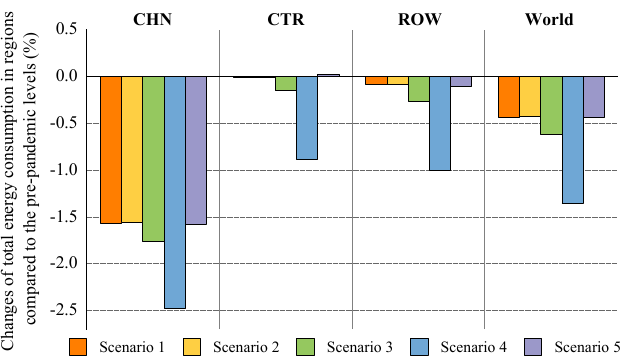
Figure 4. The impact of the COVID-19 outbreak in China on total energy consumption in trade regions in the context of trade protectionism.